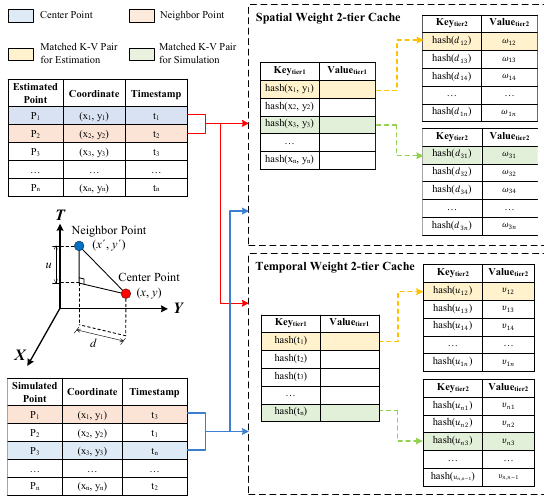
Figure 4. Cache for spatial and temporal weight reuse